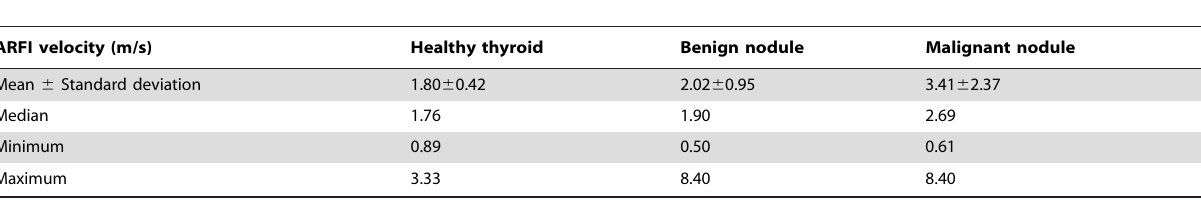
Table 3. ARFI velocity characteristics.